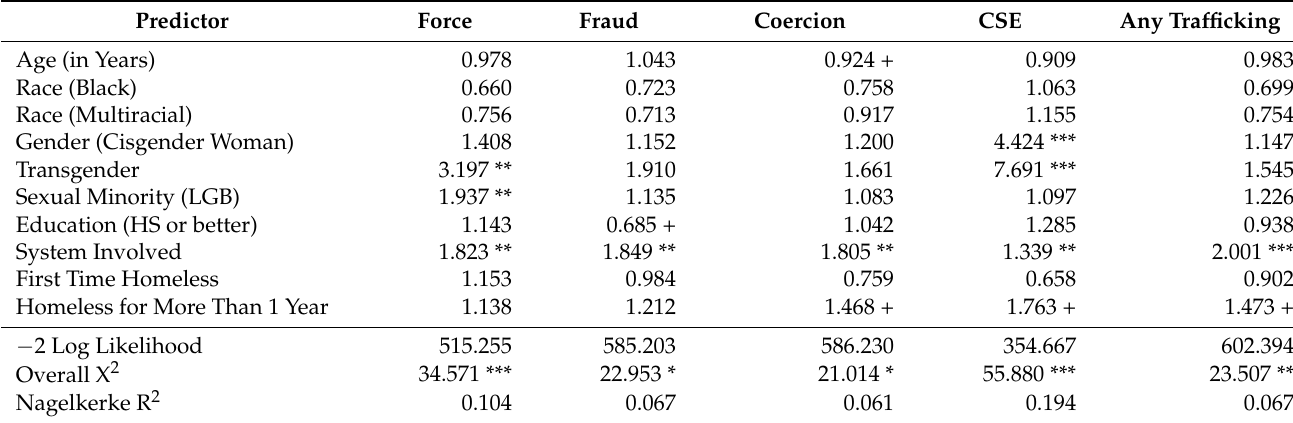
Table 5. Logistic regression analyses of each type of and any trafficking ever experienced among youth experiencing homelessness, 2018 Atlanta Youth Count (n = 455).